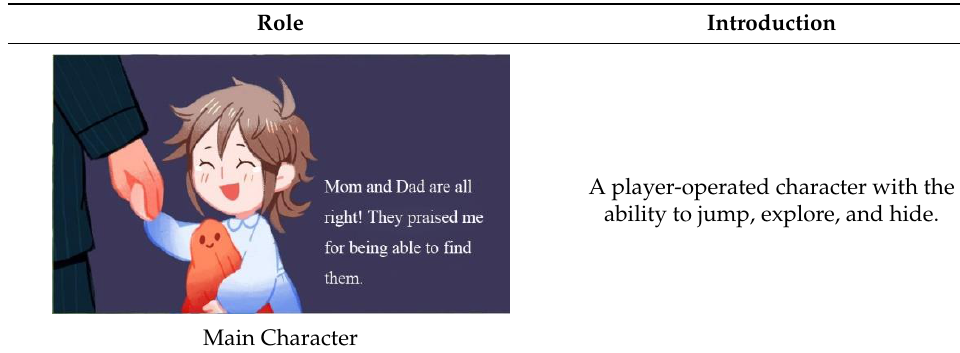
Table 7. Partial character settings.